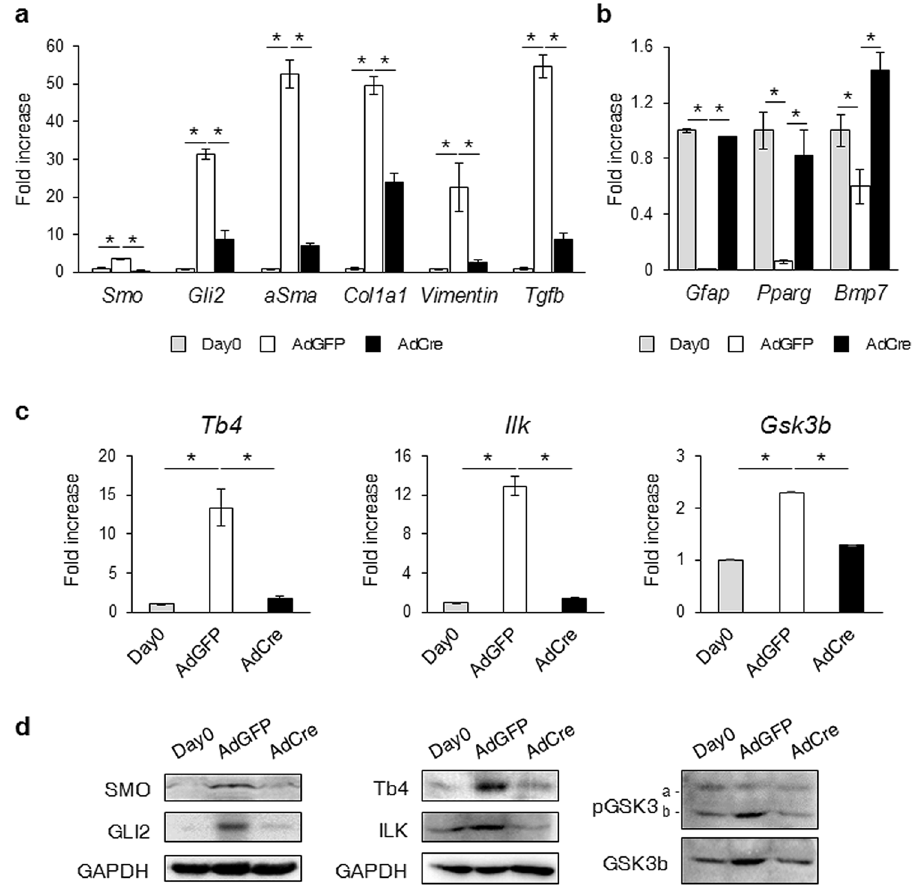
Figure 6. Deleting SMO in HSCs suppresses expression of Tb4, ILK and GSK3b. ( a ) qRT-PCR analysis for Hh signaling (S mo and Gli2 ) and markers of activated HSC ( aSma , Col1a1 , Vimentin and Tgfb ) in pHSCs at day0 (quiescent stage: white bar) and either AdGFP or AdCre-transfected pHSCs at day 7. These cells are isolated from SMO-flox. ( b ) qRT-PCR analysis for markers of quiescent HSC ( Gfap , Pparg and Bmp7 ) in these cells. ( c ) qRT-PCR analysis for Tb4 , Ilk and Gsk3b in these cells. Results are normalized to day 0 HSCs. All results of relative expression values are shown as mean ± s.e.m. of triplicate experiments ( * p < 0.05). ( d ) Western blot analysis for SMO, GLI2, Tb4, ILK, pGSK3B and GSK3B in these cells. Data shown represent one of three experiments with similar results (GAPDH was used as an internal